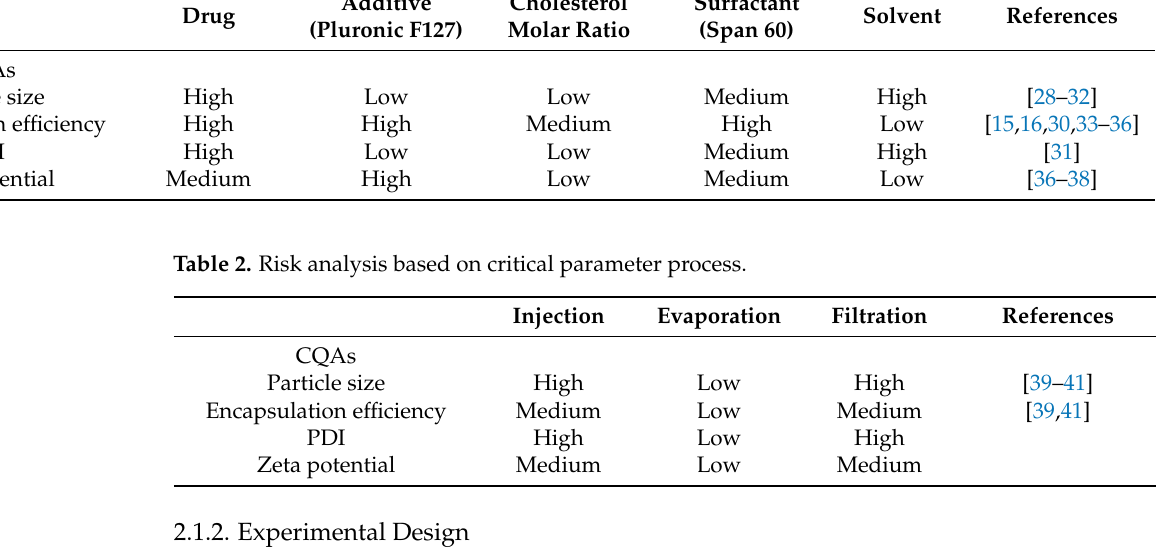
Figure 1. Ishikawa diagram for CasIII-ia formulation in niosomes with critical material attributes and critical process parameters. Table 1. Risk analysis based on critical material attributes.